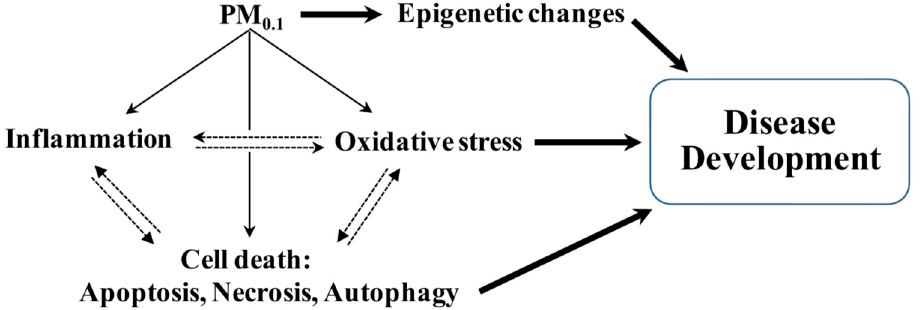
Figure 2. Intersecting pathogenic mechanisms converge to increase susceptibility to developing chronic cardiopumonary diseases assocoated with exposure to PM 0.1 .